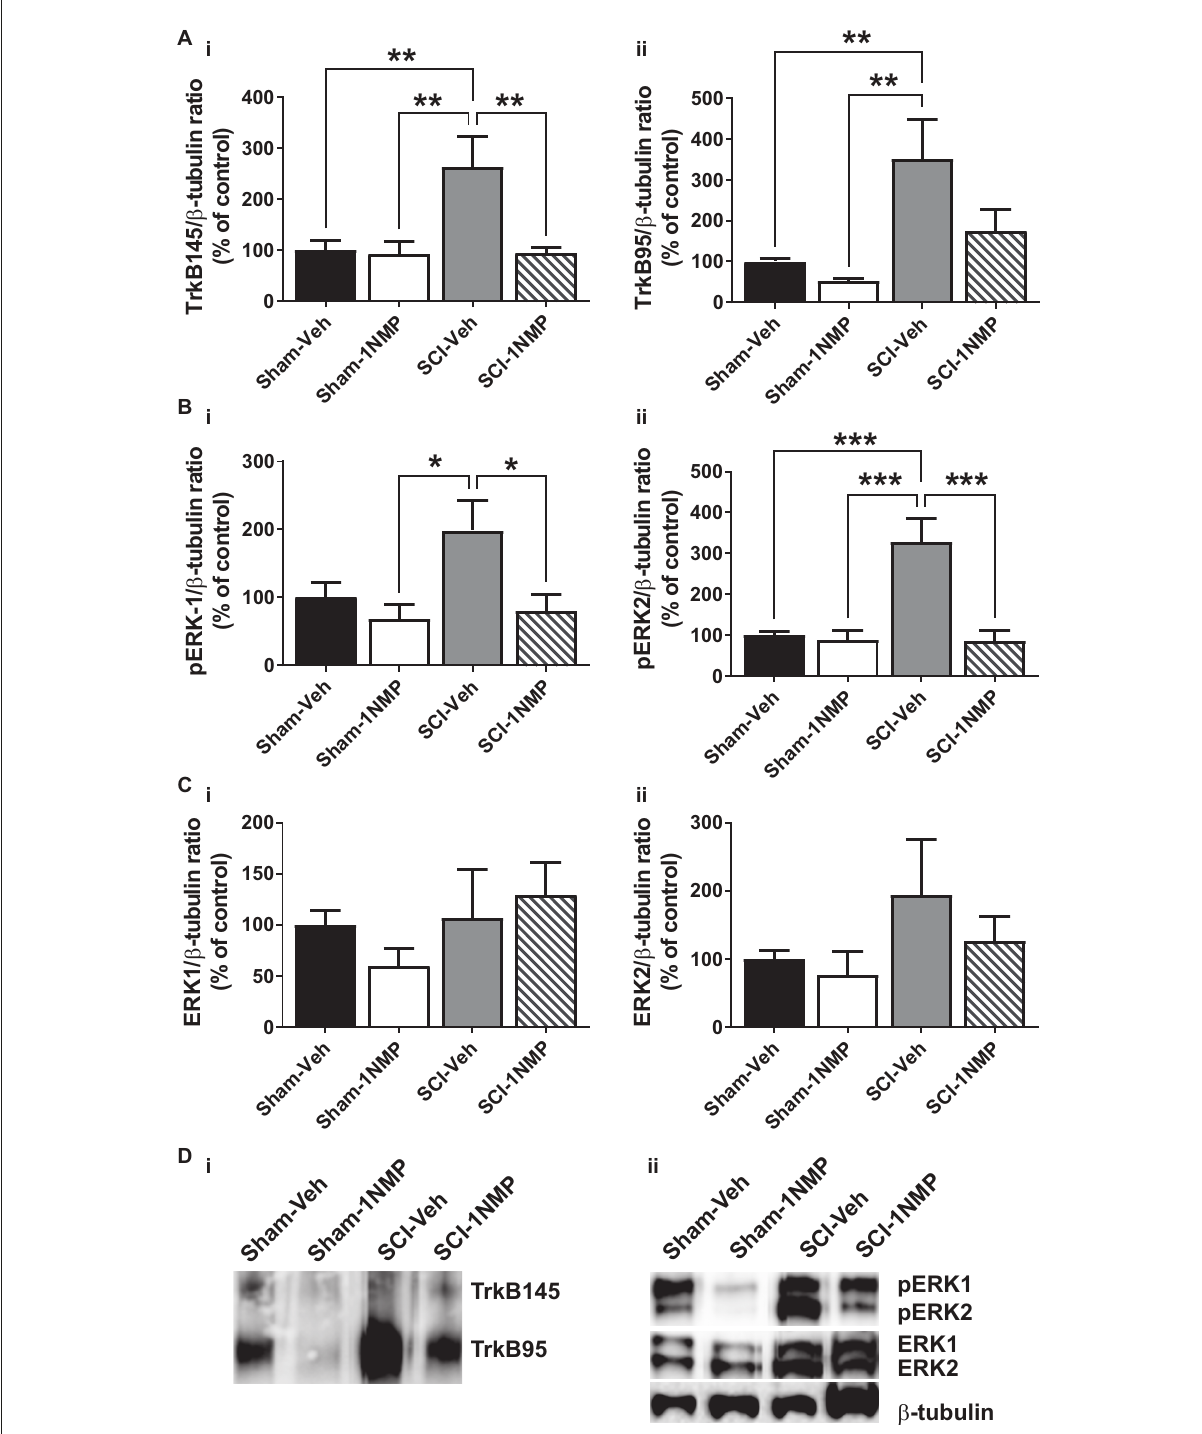
FIGURE6 Early inhibition of TrkB signaling reduces spinal TrkB and pERK expression. (A) (i,ii) SCI increased both full length and truncated TrkB expression and, (B) (i,ii) pERK1 and pERK2 levels in the lumbar spinal cord at 34 dpo. Early treatment with 1NMP (day 0–5) blocked these increases. For both TrkB and pERK proteins, the SCI-1NMP group did not differ in expression levels from the Sham-Veh or Sham-1NMP groups. (C) (i,ii) Total ERK expression levels were unchanged among the four experimental groups (* p < 0.05, ** p < 0.01, and *** p < 0.001; 1-way ANOVA, n = 6, each group). (D) Representative images of (i) TrkB, and (ii) pERK1/2, ERK1/2, and β -tubulin (loading control) Western blot are